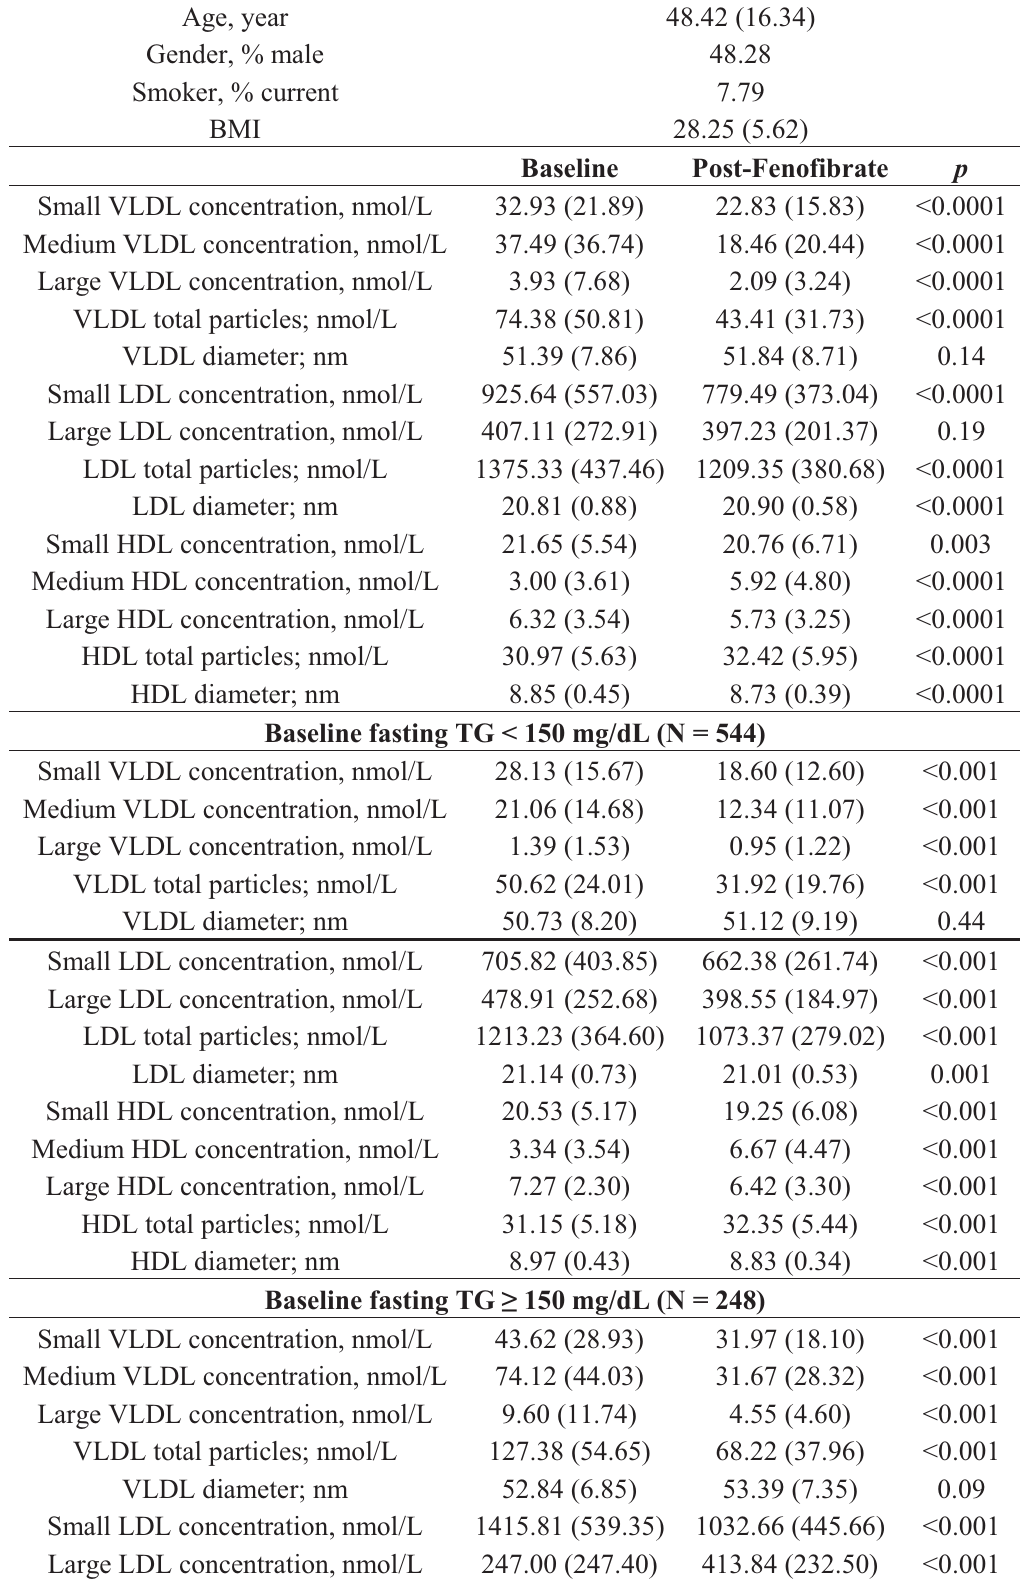
Table 2. Means (standard deviation) or percentage for demographic, anthropometric and fasting lipoprotein characteristics of the GOLDN study